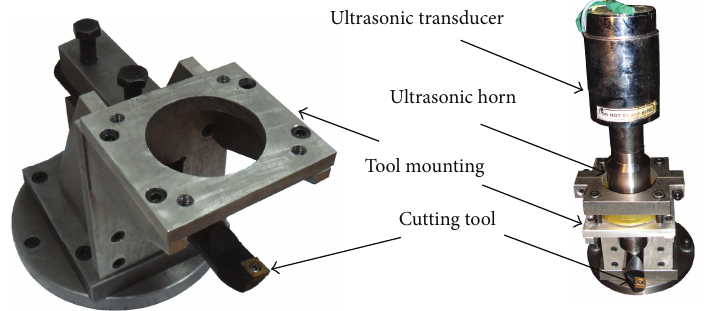
Figure 8: Fixture structure of ultrasonic vibration system.